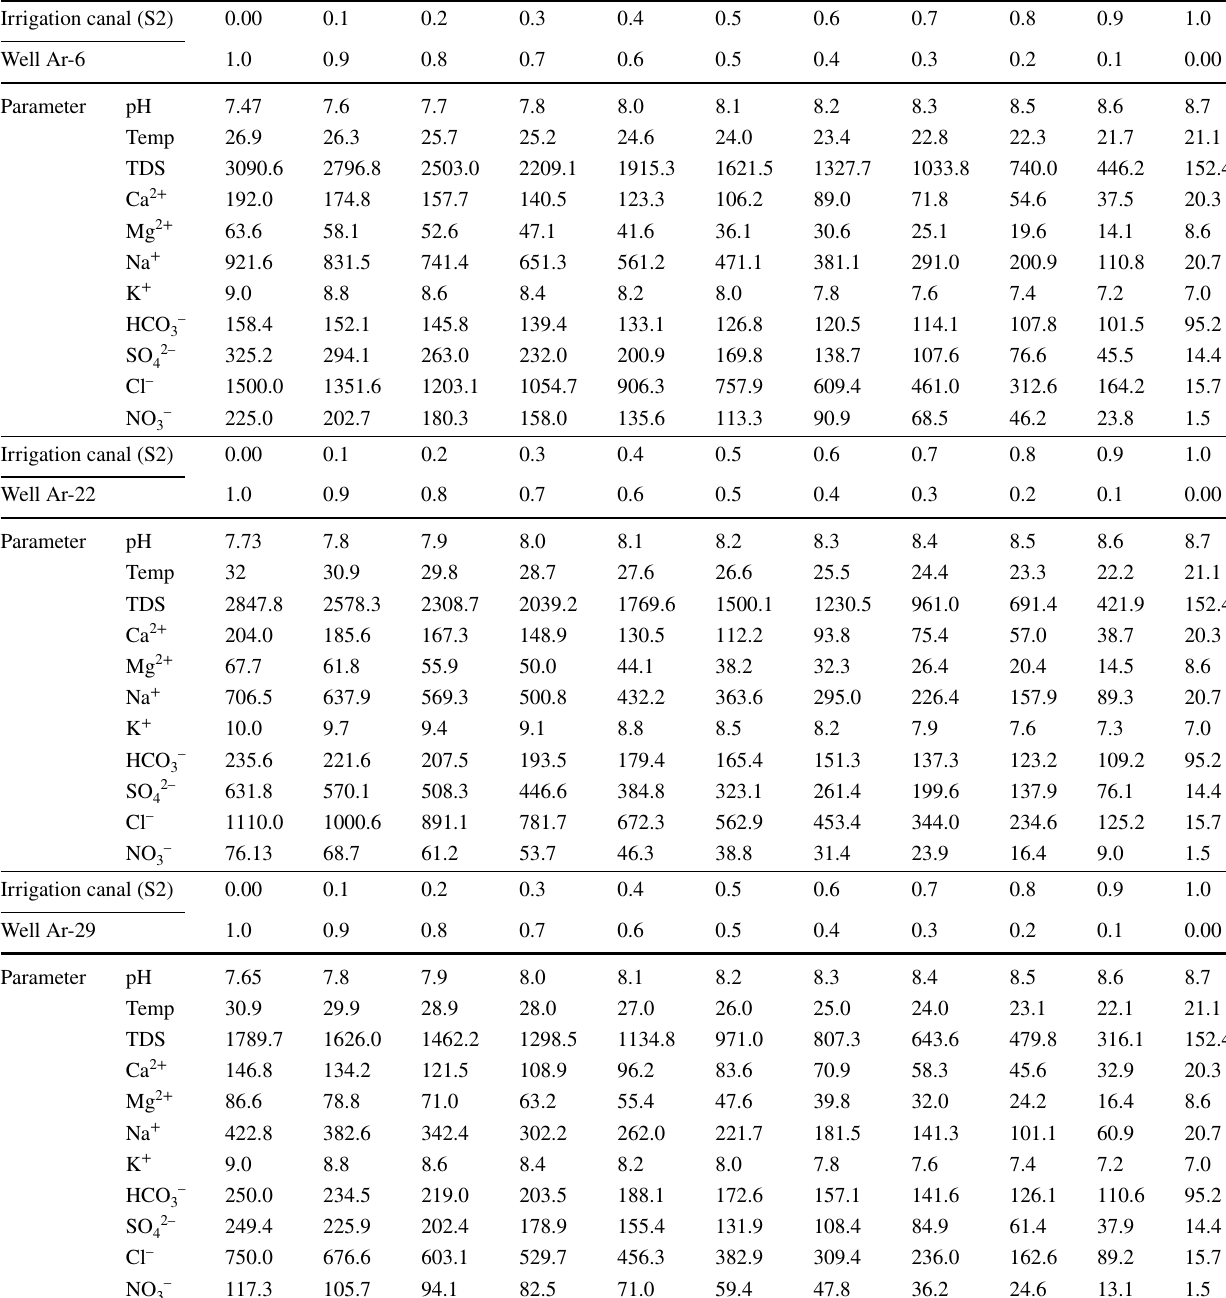
Table 10 Changes in the chemistry of wells Ar-6, Ar-22, and Ar-29 as a result of mixing with irrigation canal water (S2) Irrigation canal